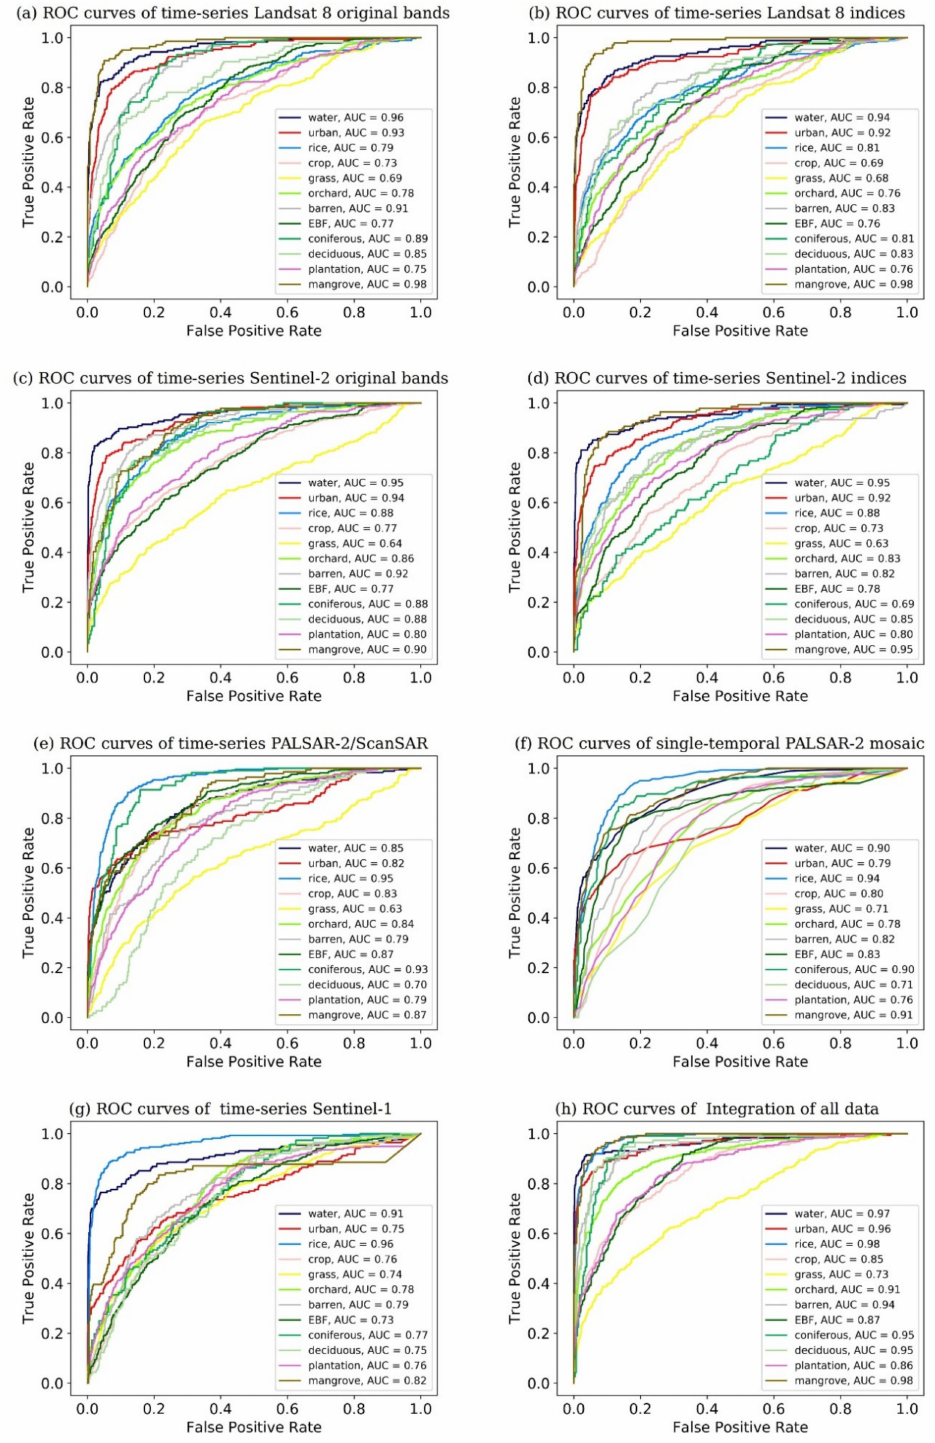
Figure 4. Receiver operating characteristic (ROC) curves of the 12 land cover categories for each input data model. ( a ) ROC curves of time-series Landsat 8 original bands; ( b ) ROC curves of time-series Landsat 8 indices; ( c ) ROC curves of time-series Sentinel-2 original bands; ( d ) ROC curves of time-series Sentinel-2 indices; ( e ) ROC curves of time-series PALSAR-2 / ScanSAR; ( f ) ROC curves of single-temporal PALSAR-2 mosaic; ( g ) ROC curves of time-series Sentinel-1; ( h ) ROC curves of integration of all